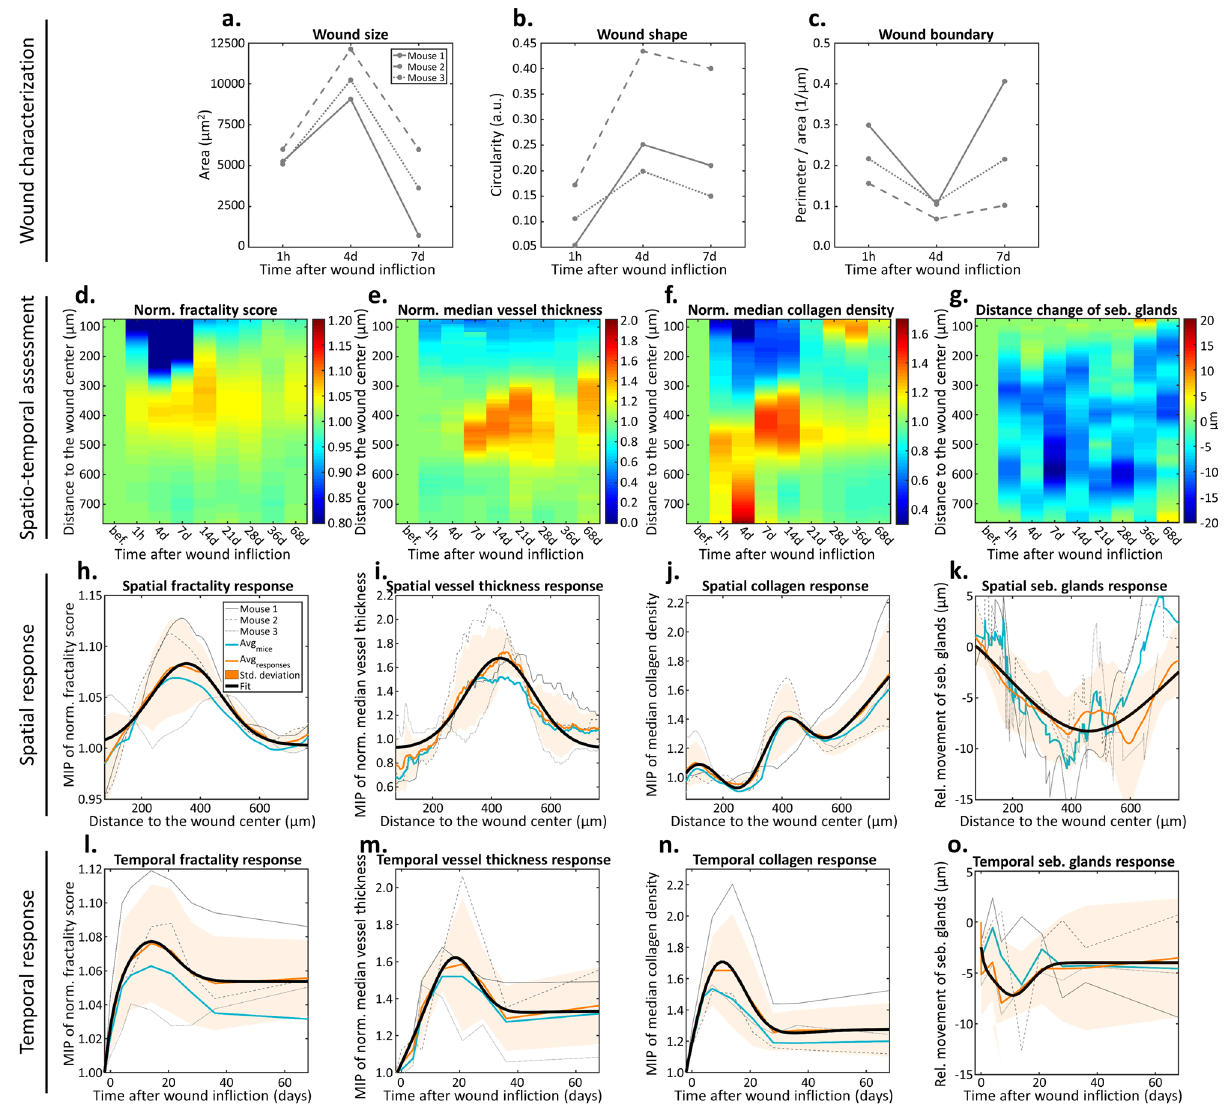
Fig. 4 Spatio-temporal assessment of the wound healing process via averaging the analysis of OA, SHG, 2PEF, and THG images of three mice. Spatial characterization of the wound towards a the wound size, b the wound shape, and c the wound boundary. Spatio-temporal maps depicting relative changes of d the fractality and e vessel thickness of the microvasculature as well as f the local collagen density and g distance change of sebaceous glands to the wound center compared to the image recorded before wound in fl iction. Maximum intensity projections (MIP) along the spatial dimension of h the normalized fractality score, i the normalized median vessel thickness, j normalized median collagen density, and k relative movement of sebaceous glands. l – o Analogous analysis along the temporal